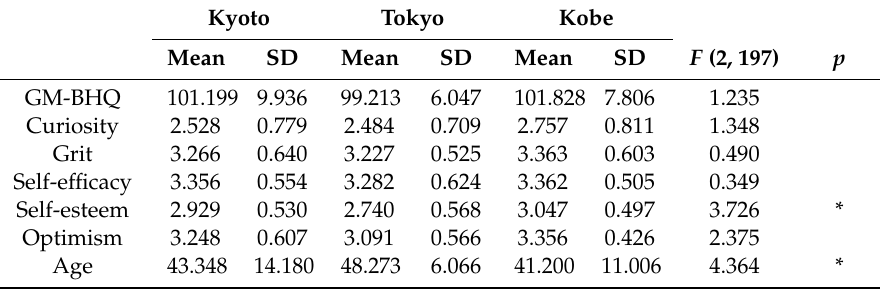
Table 3. Statistical di ff erences among places for